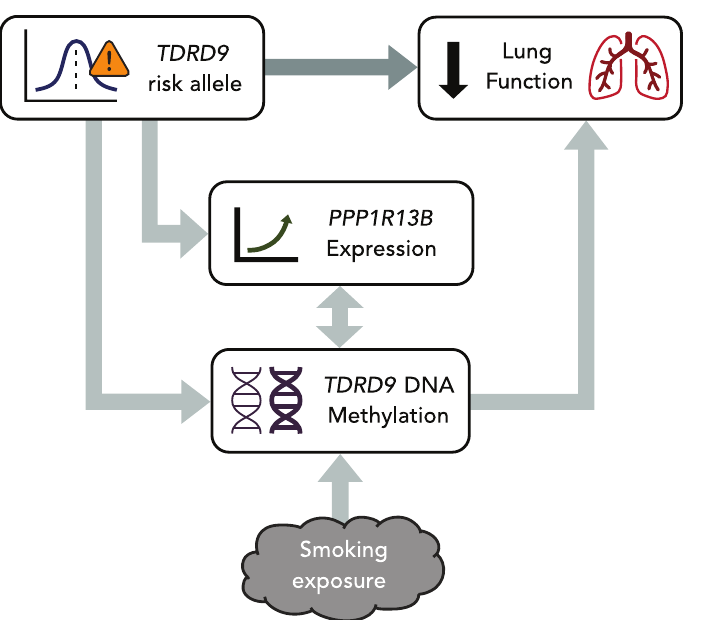
Fig 9. Summary of study associations. The TDRD9 locus was significantly associated with FEV 1 (% predicted) in the APIC and URECA cohorts. This association was partially mediated by DNA methylation at the cg03306306 CpG site in TDRD9 in NECs, which was also significantly associated with environmental tobacco smoke exposure. The TDRD9 risk allele and DNA methylation were both significantly associated with PPP1R13B gene expression, but PPP1R13B gene expression was not significantly correlated with FEV 1 itself. Unidirectional arrows represent inferred causality.